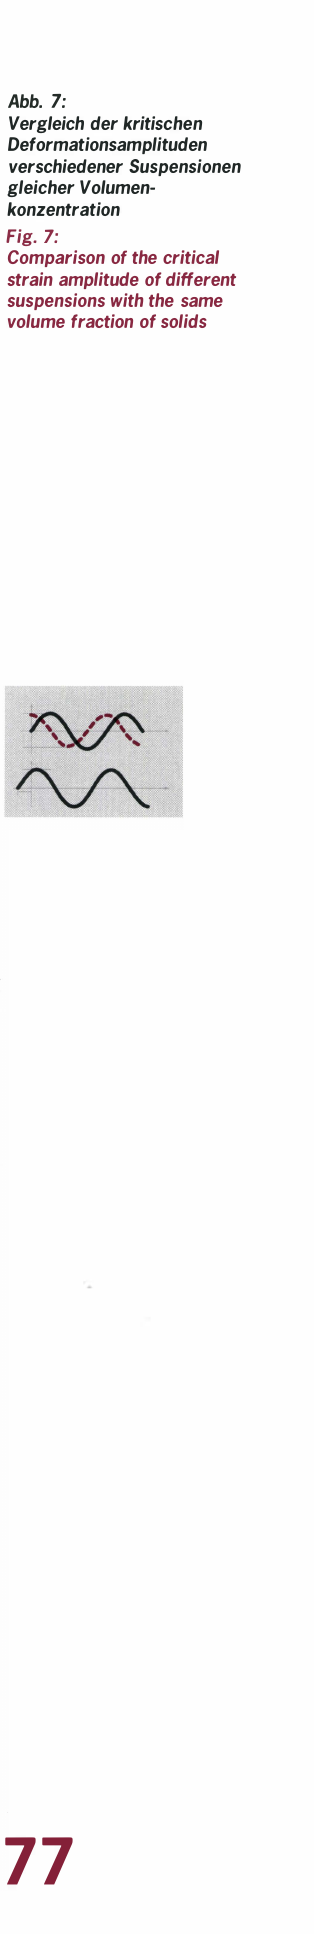
Fig. 6: Critical strain amplitudes for